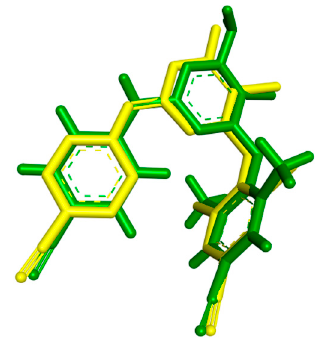
Figure 2. Conformation of TMC 125-crystal Structure (green) as Compared to the Docked Conformation of TMC 125